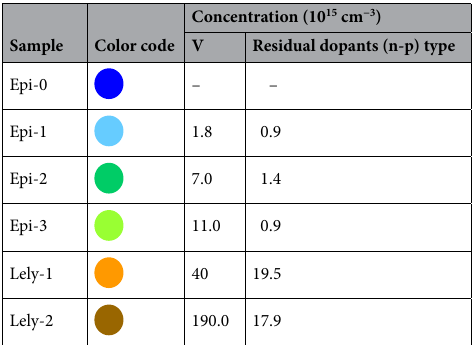
Table 1. Secondary ion mass spectroscopy (SIMS) substrate doping. Color code refers to data plotted in Fig. 2f,g